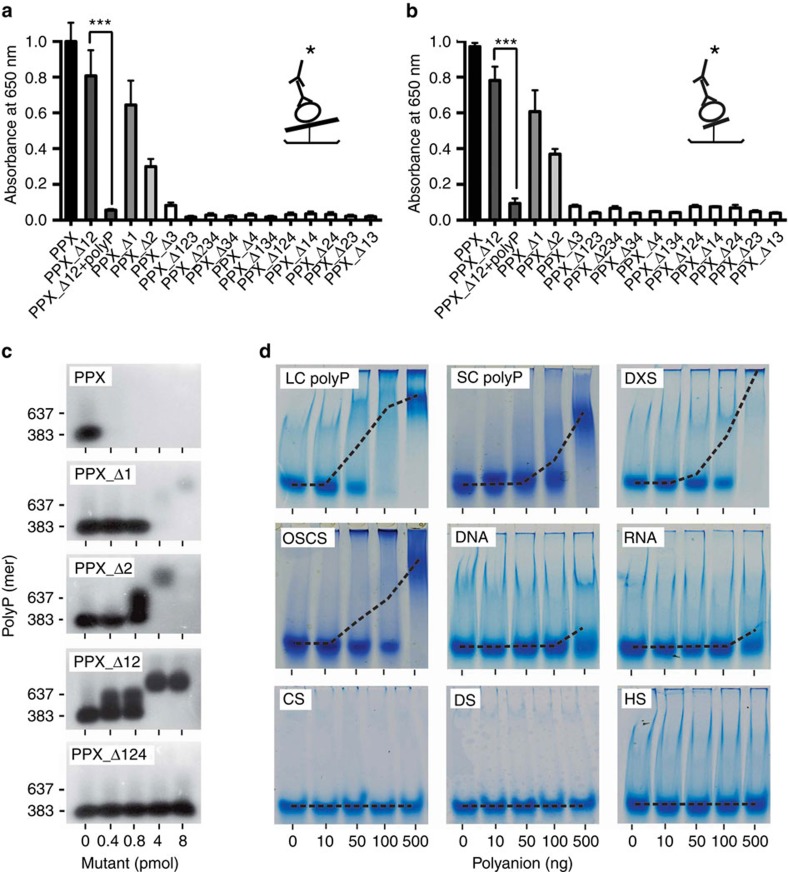
PPX variants binding to polyanions.(a,b) Immobilized long-chain (LC, a) or short-chain polyP (SC, b) was incubated for 60 min with 10 nM purified, full-size PPX, PPX deletion mutants or PPX_Δ12 preincubated with polyP. Bound PPX variants were detected using an antibody against the 6xHis-tag, an HRP-coupled secondary antibody and substrate reaction. The cartoon shows the enzyme-linked immunosorbent assay set-up with ——=LC polyP and —=SC polyP, =PPX variant, =6xHis-tag antibody and =HRP-coupled detection antibody. Shown are relative amounts of PPX variants binding to polyP. Data blotted relative to full-size PPX, set to 1.0. Mean±s.e.m., n=4, ***P<0.001 by Student's t-test. (c) Gel mobility shift assay of full-size PPX, PPX_Δ1, PPX_Δ2, PPX_Δ12 and PPX_Δ124 binding to polyP. Increasing concentrations of PPX mutants (0–400 nM) were incubated with polyP (7.5 μg ml−1) for 30 min, and reaction mixtures containing 0–8 pmol mutant protein per lane were resolved on 1% agarose gels. PolyP was visualized with DAPI-negative staining and synthetic polyP with mean chain length of 383 and 637 phosphate units served as molecular size standard. (d) PPX_Δ12 (400 nM) was incubated for 30 min with increasing concentrations of various polyanions including LC polyP, SC polyP, dextran sulfate (DXS), oversulfated chondroitin sulfate (OSCS), DNA, RNA, chondroitin sulfate (CS), dermatan sulfate (DS) and heparan sulfate (HS). PPX_Δ12/polyanion complexes were dissolved on urea-polyacrylamide gels and PPX_Δ12 protein was stained with Coomassie brilliant blue. The dashed line gives PPX_Δ12/polyanion complex formation assessed by densitometric scans. A representative gel of three independent experiments is shown.